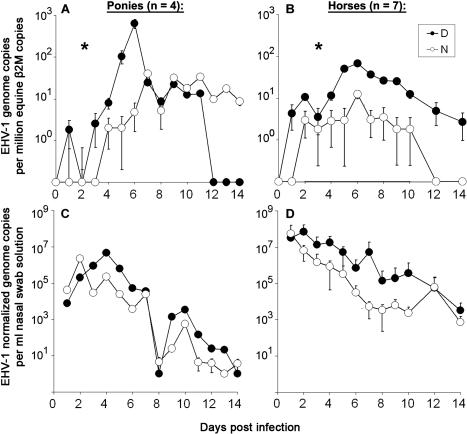
Real-Time Quantitative PCR Data from the Equine Experimental Infection StudiesResults from studies conducted on ponies (A and C) and horses (B and D) with the revertant pol genotype virus (D752, •) and mutant virus (N752, ○). *p < 0.05.(A and B) Geometric means of normalized lymphocyte-associated viremia measured by qPCR, with EHV-1 DNA copies normalized per million cellular genomic DNA copies.(C and D) Virus titers in nasal excretions measured by qPCR. Shown are geometric mean normalized viral genome copies per milliliter of nasal swab solution. Standard deviations (error bars) are plotted, but are small compared to the y-axis scale and thus not visible for some data points. Data from the first experiment (ponies, four animals/group) are shown in the left graphs (A and C), those from the second experiment (horses, seven animals/group) in the right graphs (B and D).